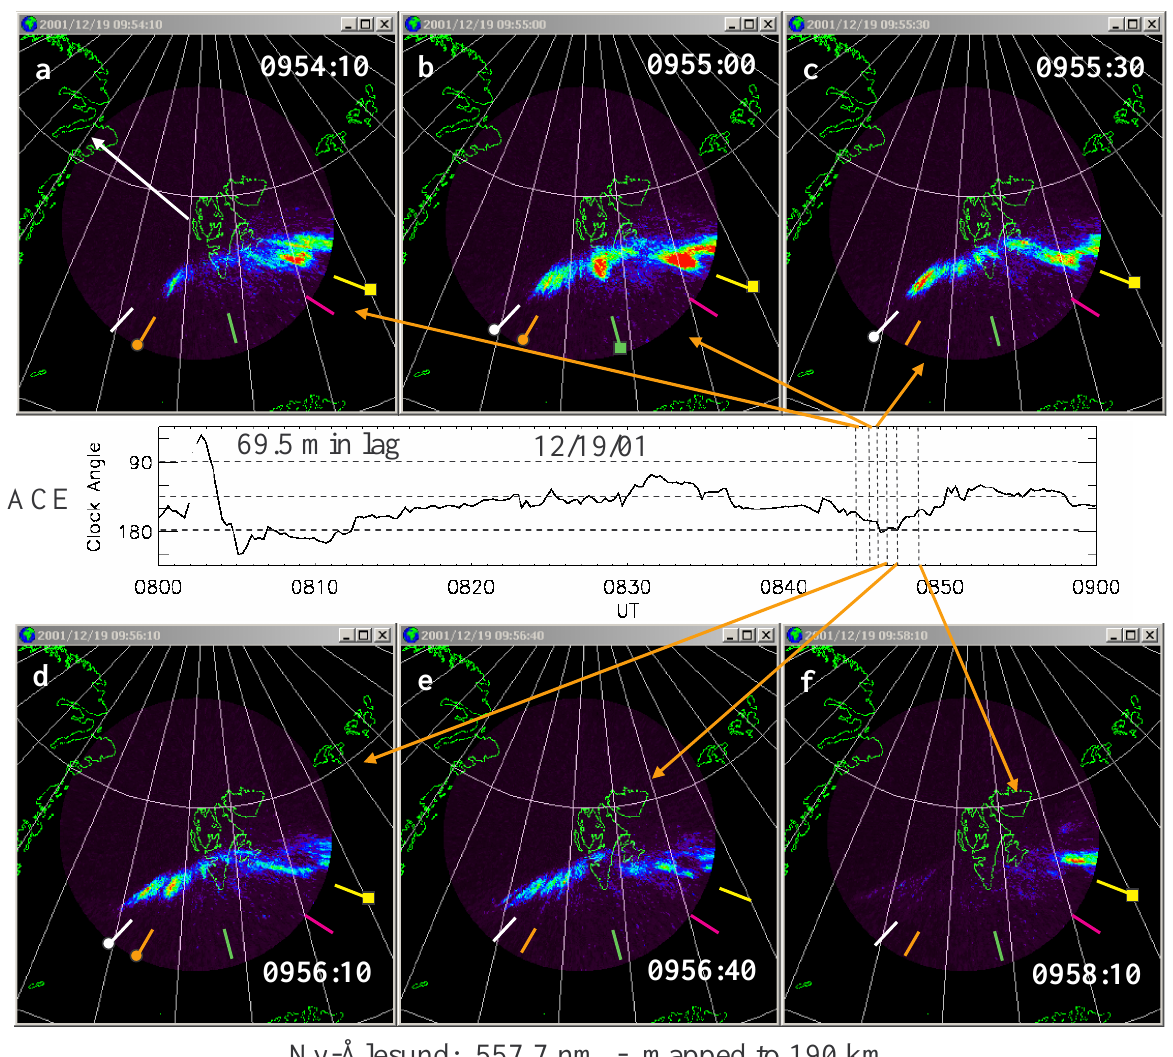
Fig. 7. Continuation of the sequence in Fig. 6 with six more images related to the ACE IMF clock angle with the 69.5-min lag. Fiducials of Fig. 5 appear where